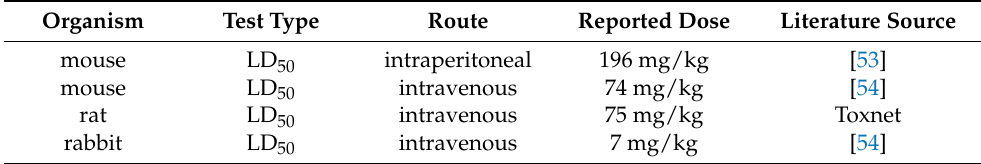
Table 2. Published acute and subacute toxic parameters of